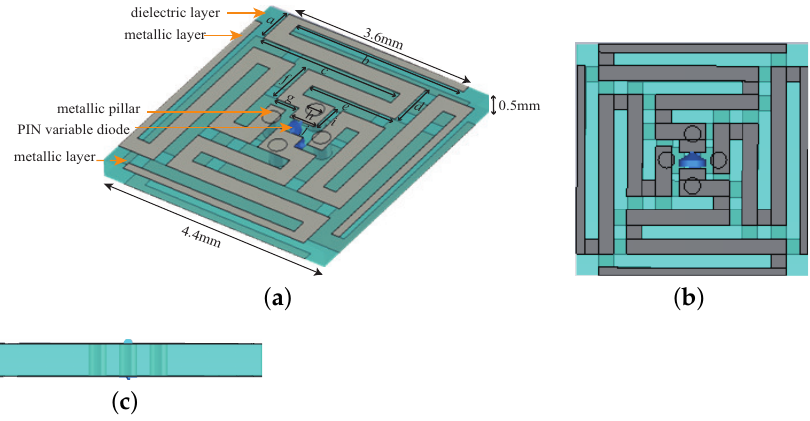
Figure 1. Three − dimensional schematic diagram of the unit cell (dimensions: a = 0.7 mm, b = 3.3 mm, c = 2.75 mm, d = 0.85 mm, e = 1.65 mm, f = 0.85 mm, g = 0.45 mm, h = 0.3 mm, i = 0.55 mm, j = 0.5 mm. ( a ) Oblique view. ( b ) Top view. ( c ) Side